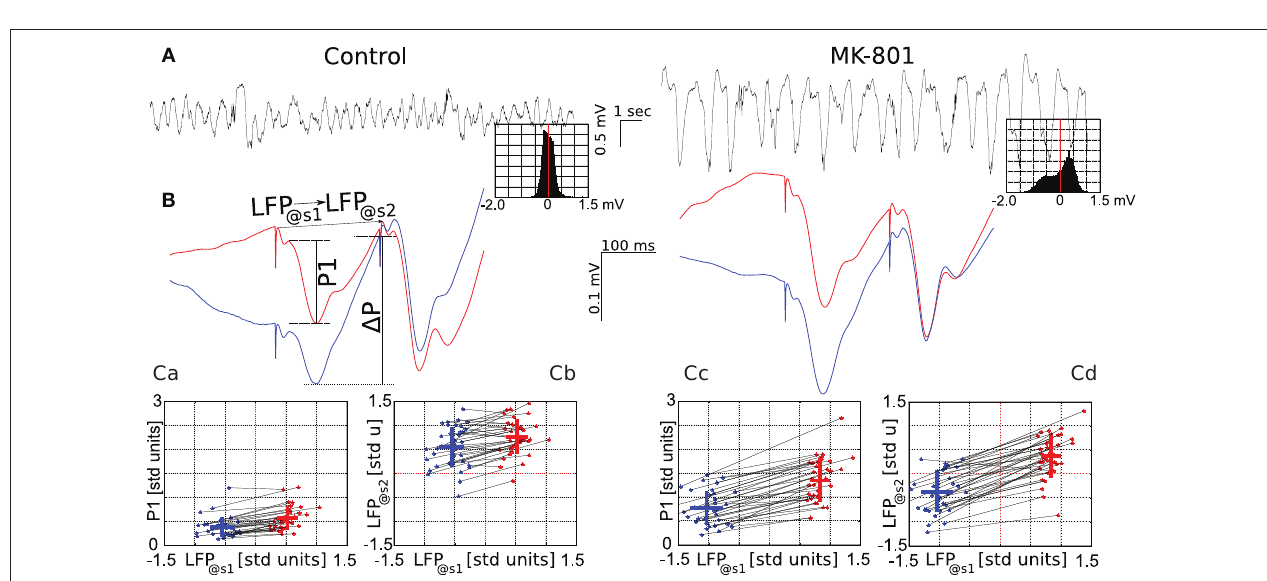
Figure 2 | effect of systemic administration of MK-801 (0.05 mg/kg, i.v.) on field potential oscillations in the medial prefrontal cortex . Before drug administration the LFP is characterized by a regular, approximately 2 Hz frequency, 0.5 mV amplitude rhythm, termed high‑delta oscillation. Effects of